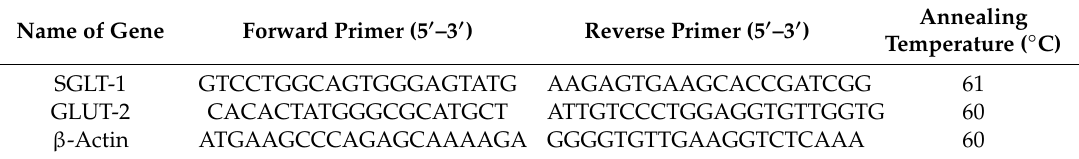
Table 2. Primer sequences used during real-time